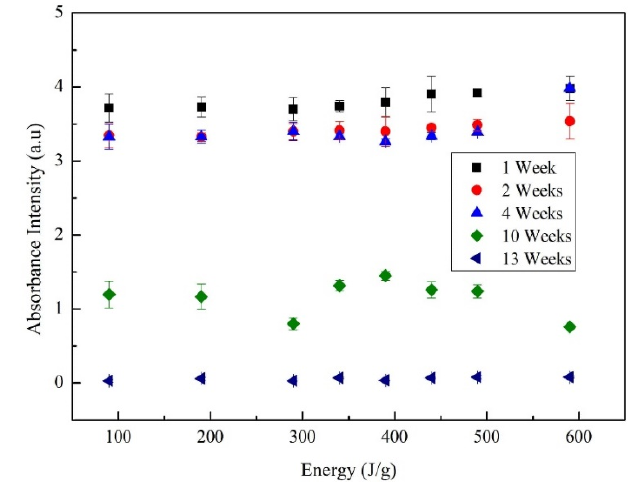
Figure 6. Evolution of absorbance at 300 nm of MWCNT / TX-100 / H 2 O at di ff erent sonicator energies with constant molarity of 10